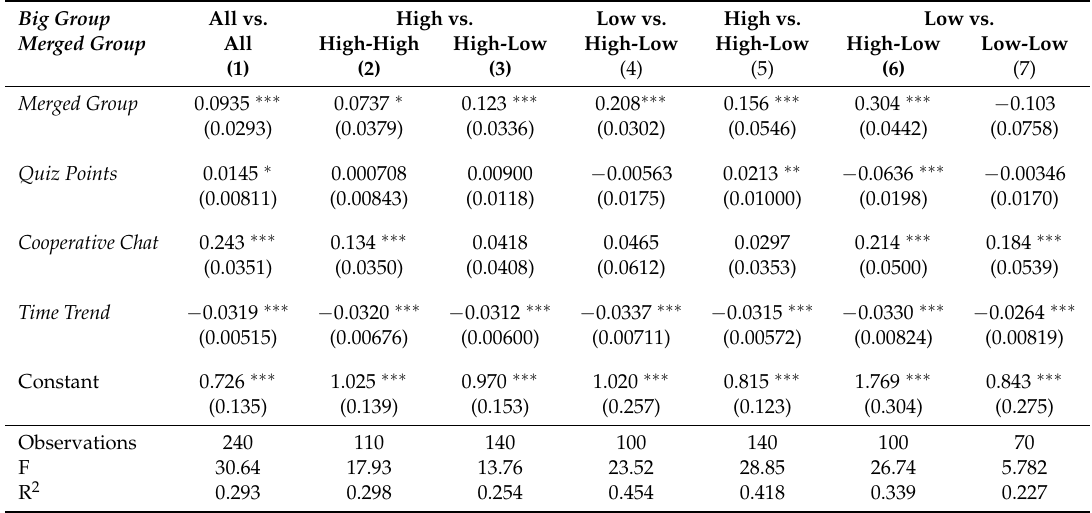
Table A18. Linear regressions: between treatment helping rates in Part B—with controls. Big Group All vs. High